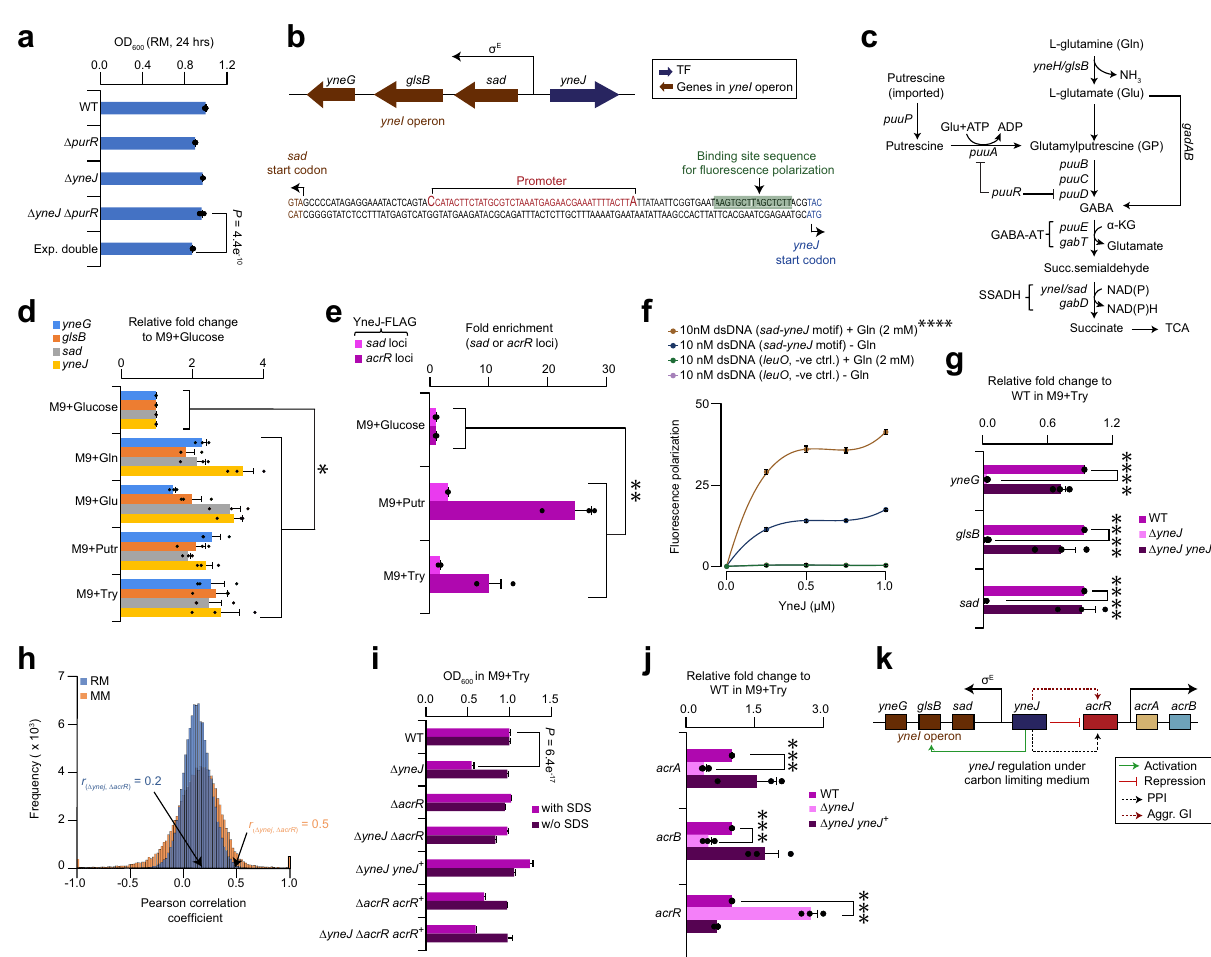
Fig. 4 YneJ regulates the components of putrescine pathway and ef fl ux pump. a Growth rate of indicated strains at 32 °C with OD 600 measured ( n = 10 biologically independent experiments; P = 4.4 e − 10 by Student ’ s two-sided t -test) at 24 h in RM. b Location of yneJ near the σ E promotor region of yneI operon, comprising sad-glsB-yneG genes, with DNA binding site (highlighted in green) predicted within the sad-yneJ intergenic region based on conservation analysis. c Genes in putrescine utilization and Gln-Glu pathways. d Transcript levels of indicated genes in a wild-type (WT) BW25113 strain grown in M9 media with different carbon sources (0.5% Gln, Glutamine; 0.5% Glu, Glutamate; 0.4% Putr, Putrescine; 1% Try, Tryptone) relative to 0.1% M9-glucose ( n = 3 biologically independent experiments). e Fold enrichment of YneJ binding site in sad-yneJ or acrA - acrR intergenic region measured by ChIP-qPCR ( n = 3 biologically independent experiments) in M9-putrescine, tryptone and glucose media. ChIP enrichment in a chromosomal YneJ FLAG 3 - tag normalized to a negative control (i.e., primers designed away from YneJ binding site of sad or acrR was used to amplify from YneJ-FLAG 3 ). f YneJ binding to sad-yneJ site by fl uorescence polarization ( n = 4 biologically independent experiments) is shown at increasing concentration of YneJ recombinant protein with 10 nM fl uorescence-labeled double-stranded DNA (i.e., sad-yneJ consensus motif or promoter region of leuO gene that serve as negative control), and in the presence or absence of Gln (2 mM). Signi fi cance (**** P = 1.7 e − 9 ) calculated using Student ’ s two-sided t -test between sad- yneJ consensus motif with Gln vs. without Gln at 1 µ M concentration of YneJ protein. g Transcript levels of target genes measured by qRT-PCR ( n = 3 biologically independent experiments) in yneJ mutant or complemented ( + ) strains vs. WT grown in M9-tryptone. h Distribution of correlation coef fi cient pro fi les among TFs, with emphasis on yneJ - acrR GI pro fi le ( n = 300 gene pairs) in RM and MM. i Growth rates of WT and indicated mutant or complemented ( + ) strains in M9 media containing tryptone, with or without SDS ( n = 12 biologically independent experiments; P = 6.4 e − 17 by Student ’ s two-sided t -test) at 32 °C over 24 h. j Changes in transcript levels of target genes in yneJ mutant or complemented ( + ) strain vs. WT grown in M9- tryptone ( n = 3 biologically independent experiments). k Model illustrating YneJ role in the regulation of Puu and ef fl ux pump. Data ( a , d – g , i , j ) are presented as mean ± standard deviation from the indicated number of independent samples. Signi fi cance in panels d , e , g and j (* P ≤ 0.05, ** P ≤ 0.01, *** P ≤ 0.001, **** P ≤ 0.0001) calculated by Student ’ s two-sided t -test. Source data are provided as a Source Data fi